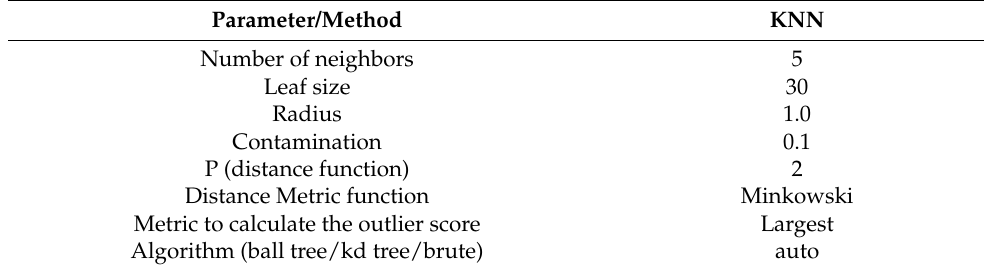
Table 5. KNN setting parameters utilized in both SUN and UUN approaches.